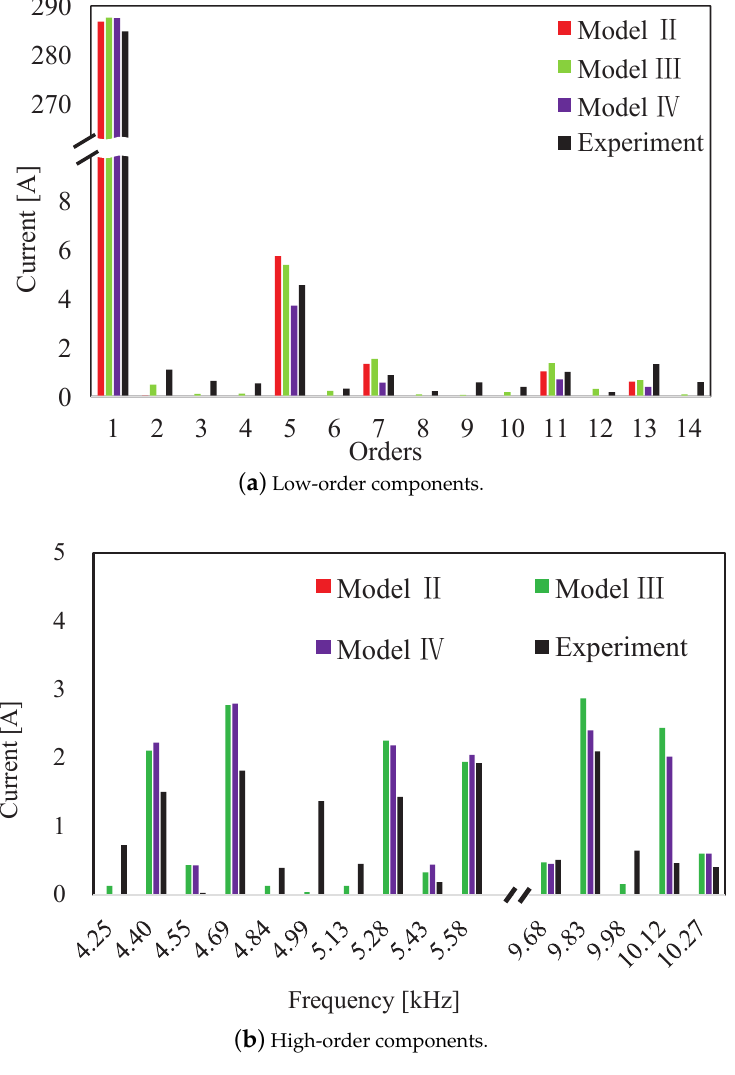
Figure 10. Comparison of current harmonics in different models. ( a ) Low-order components. ( b ) High-order